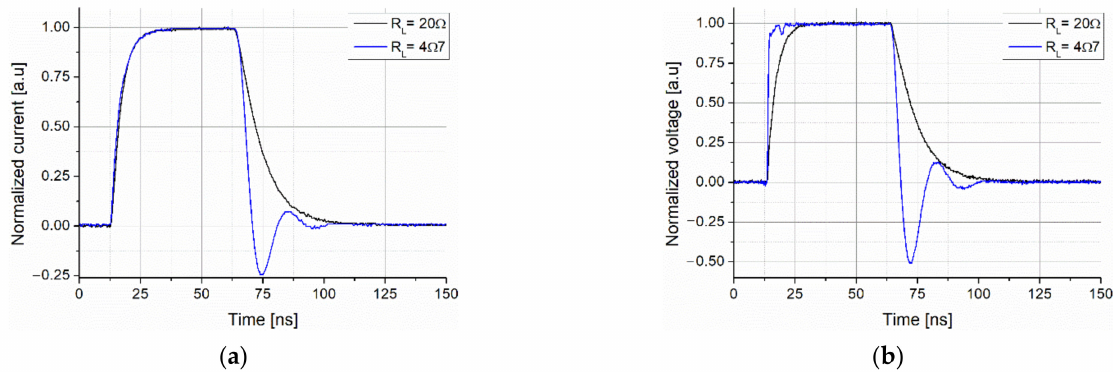
Figure 4. Normalized electrical driving signals: current ( a ) and voltage ( b